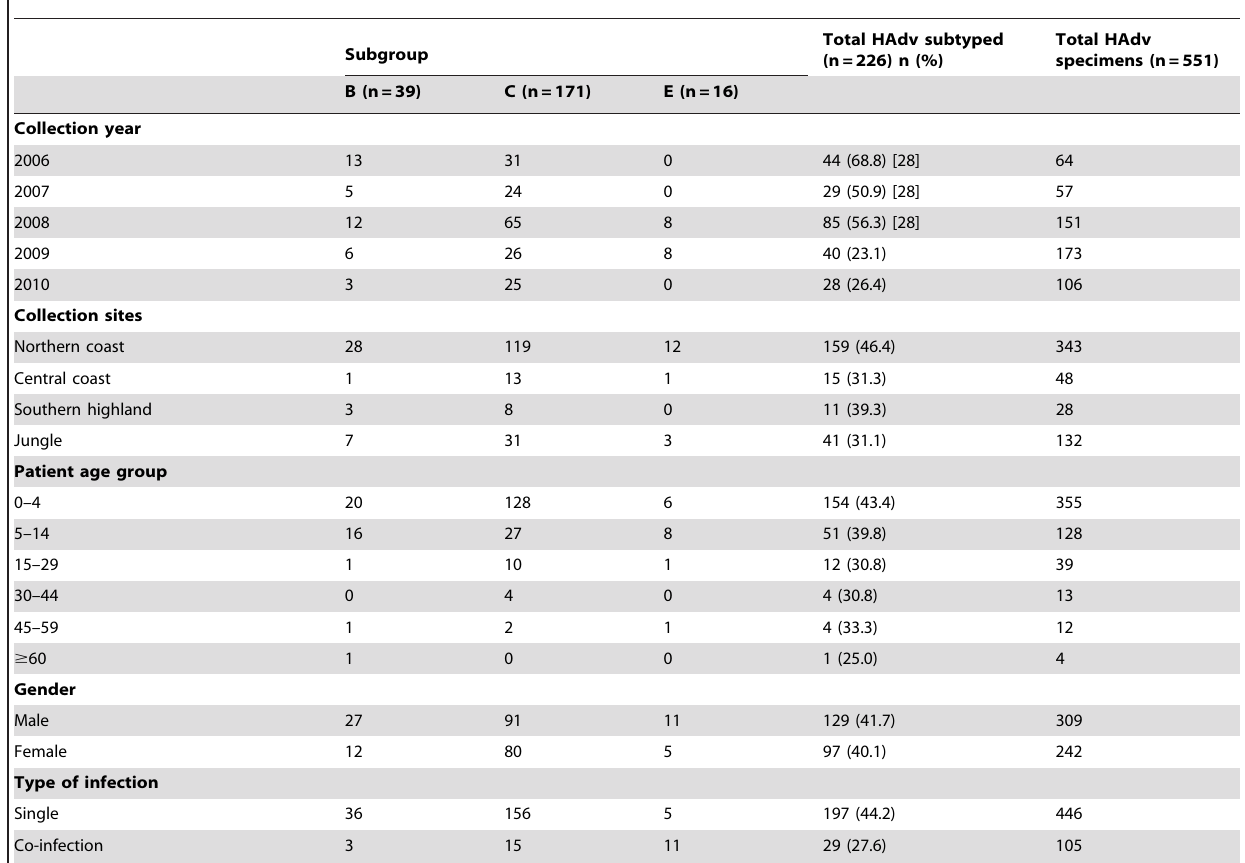
Table 4. Distribution of genotyped samples per collection year, region, age group, gender, and type of